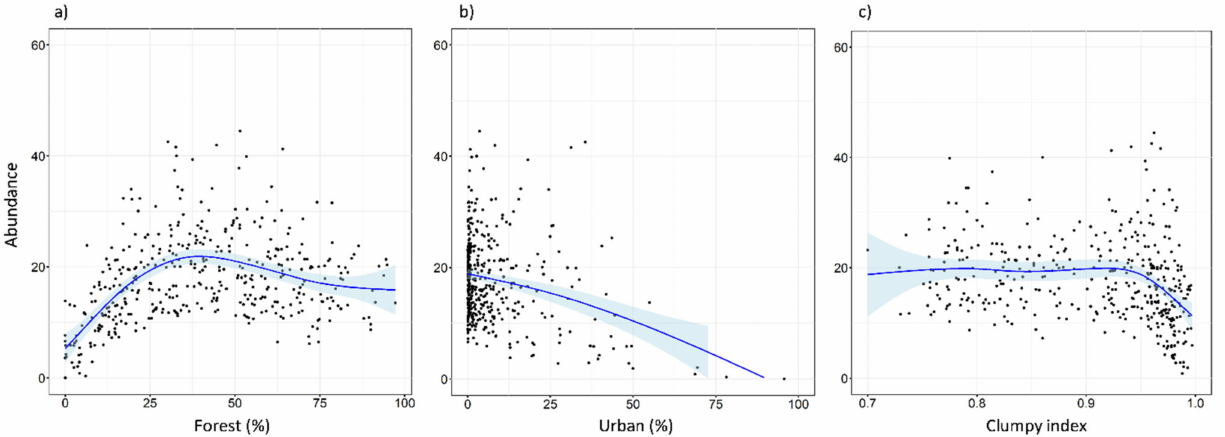
Figure 2. Expected abundance of tawny owl ( Strix aluco ) at the local scale and based on the top-ranked model in relation to ( a ) forested gradient, ( b ) urban gradient, and ( c ) clumpiness index. The clumpiness index represents the aggregation level of habitat patches (in our case, urban patches). It is equal to − 1 when the urban patch is maximally disaggregated, 0 when it is randomly distributed, and 1 when maximally aggregated. The blue lines show a cubic smoothing spline fitted to the data in order to show the general trend, while shaded areas show standard error boundaries.